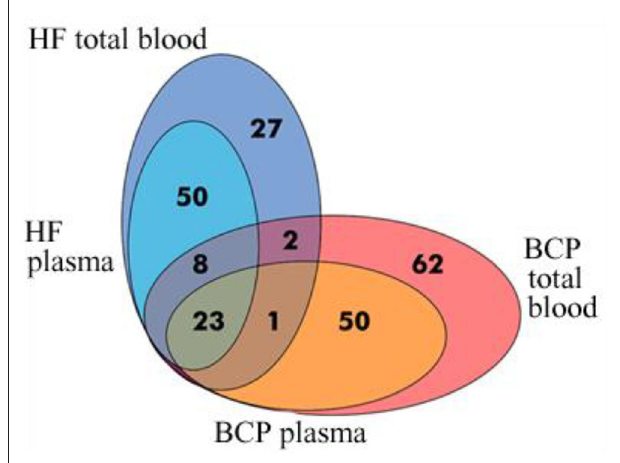
FIGURE 2 | Venn-Euler diagram of proteins in exosomes from HF and BCP blood, composed using FunRich software.